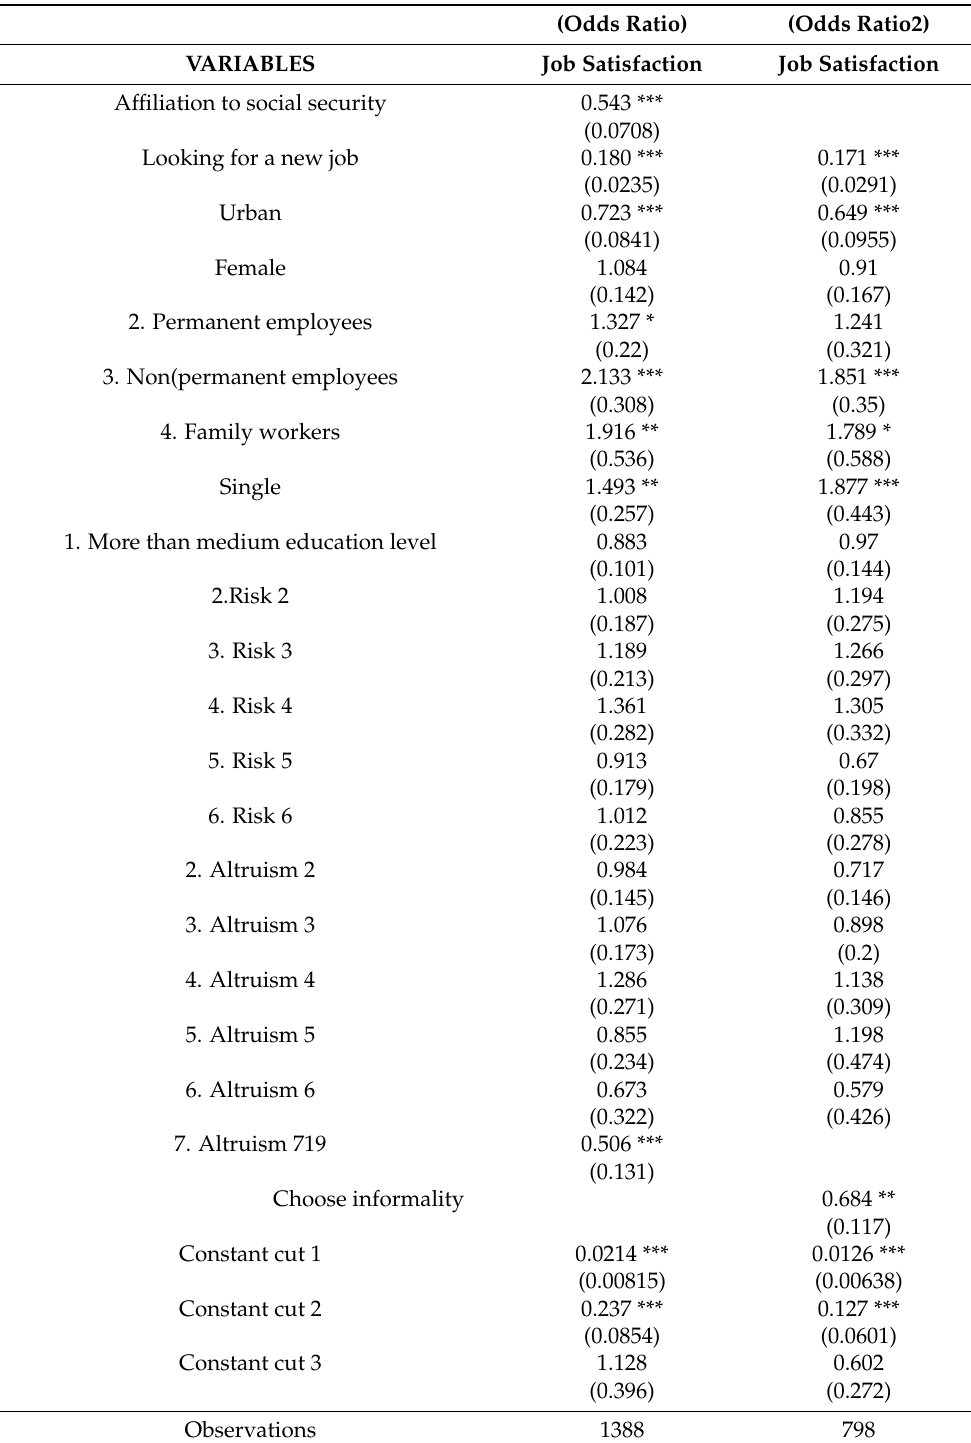
Table A9. Ordered logit model; the dependent variable is job satisfaction. Ordered form very satisfied to not at all satisfied. Source: Sahwa survey and Stata